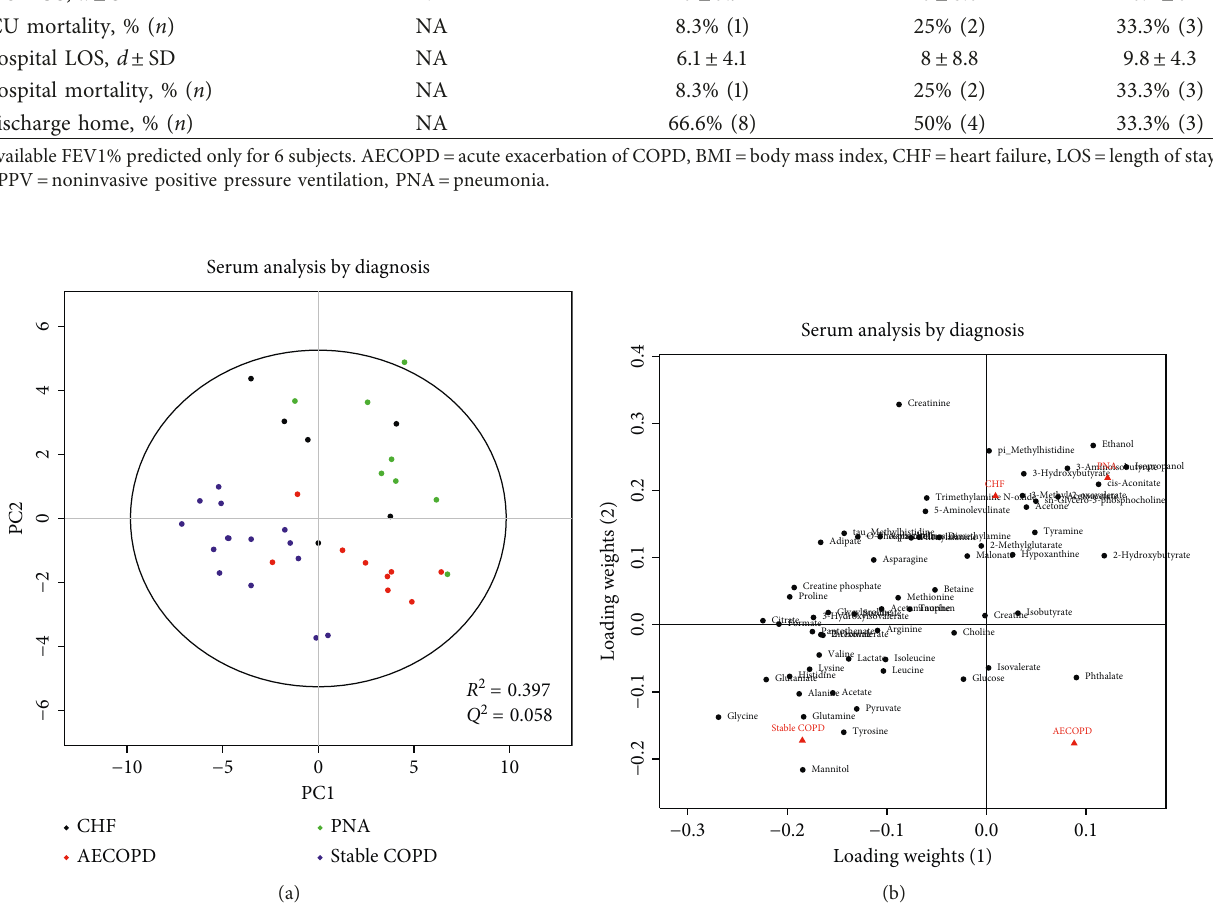
Figure 1: PLS-DA score plots (a) and loading plots (b) of serum samples drawn from patients with stable COPD (blue), AECOPD (red), CHF (black), or PNA (green). Each circle represents a serum sample. Some separation between the groups can be seen. The loading plot shows how the profiled metabolites contribute to the separation seen in the scores. The model is statistically significant ( p (cid:136) 0 . 001), but the fit is moderate at best ( R 2 (cid:136) 0.397) with poor predictive value ( Q 2 (cid:136) 0.058). Taken with the rest of the results, our interpretation is that the separation is likely due to the presence of respiratory failure.